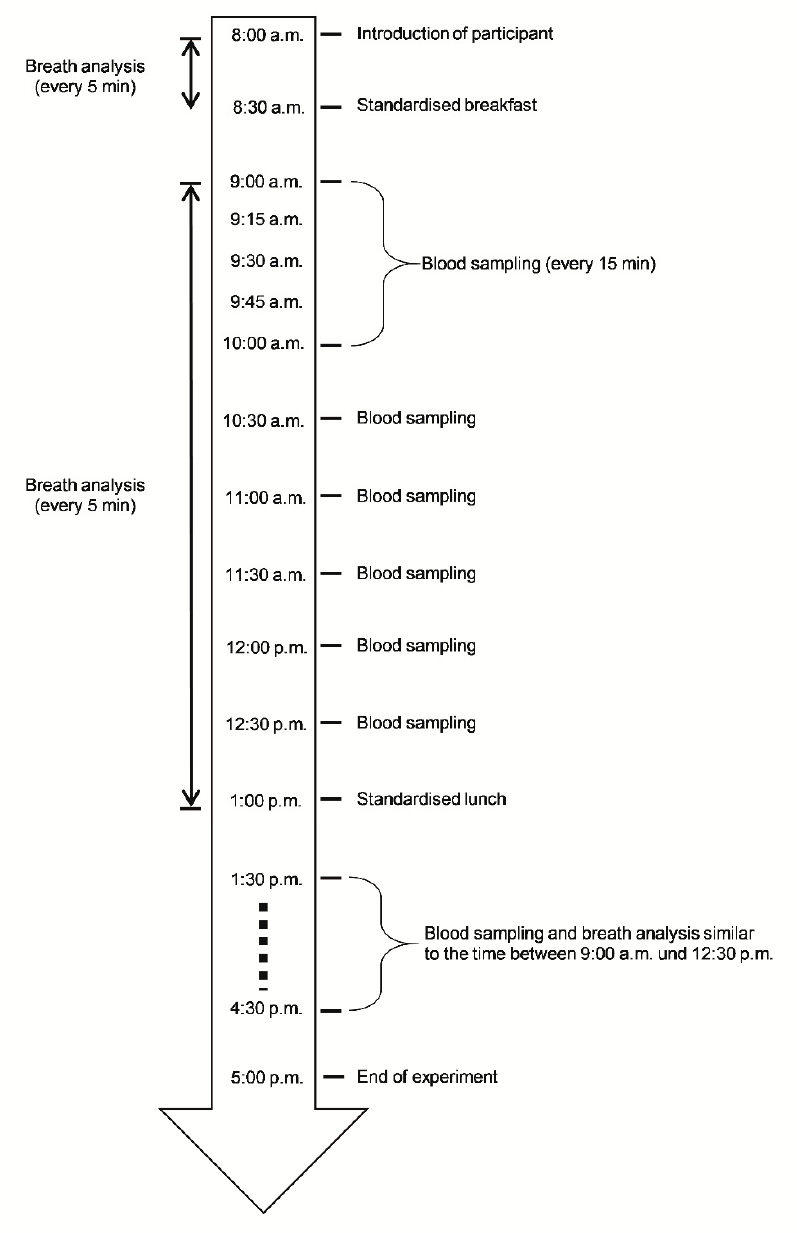
Figure 1. Representation of the study design. Insertion of continuous glucose monitoring (CGM) took place the evening before and placement of an indwelling venous canulae was done on the morning before breakfast. Total number of blood samples was 22 and at least 93 breath samples were measured per participant. At the times indicated, blood was drawn for preparation of